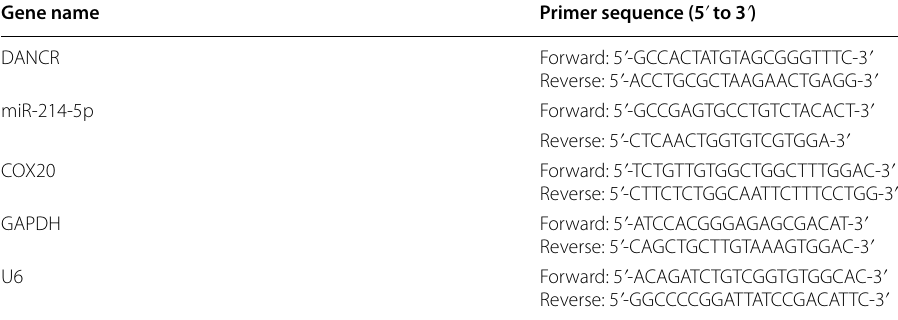
Table 2 The sequences of specific primers Gene